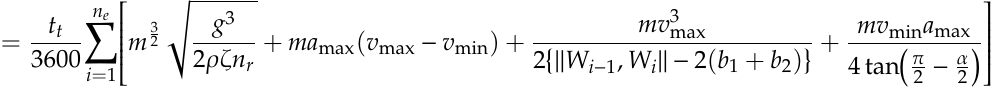
Figure 4. Analysis of flight path using the Dubins path method [18–20].